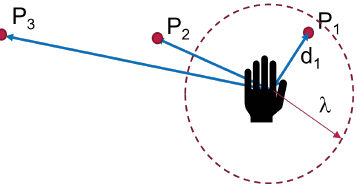
Figure 4. Pictorial representation of strategy 2. Algorithm 2 Strategy 2: Hand position with